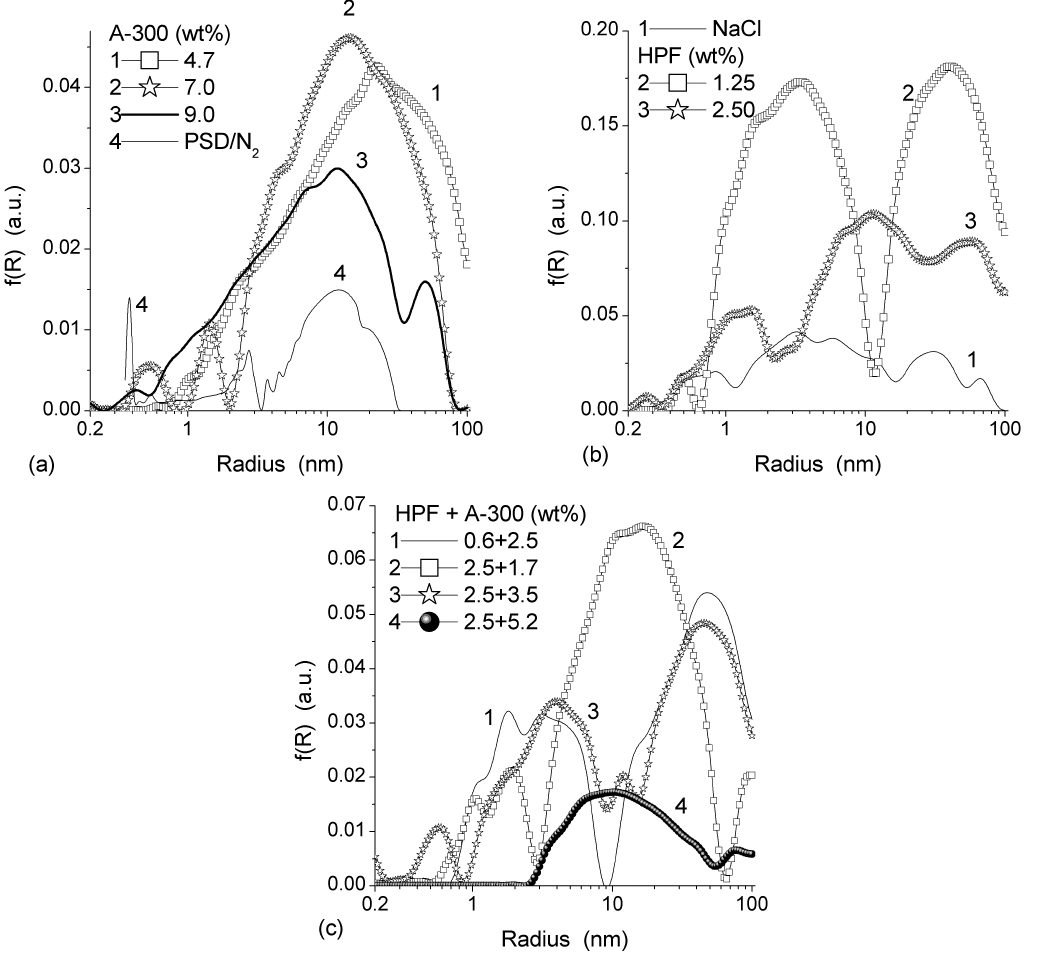
Fig. 7 The size distributions of pores filled by unfrozen water for (a) aqueous suspension of A-300 and the PSD calculated on the basis of the nitrogen adsorption/desorption isotherm (with the model of voids between spherical particles with the CONTIN/MEM-0 regularization); (b) 0.15 mol NaCl or HPF solution at 1.25 and 2.5 wt%; and (c) HPF/A- 300 at different concentrations of protein and silica (CONTIN/MEM-0 regularization applied to Eq.